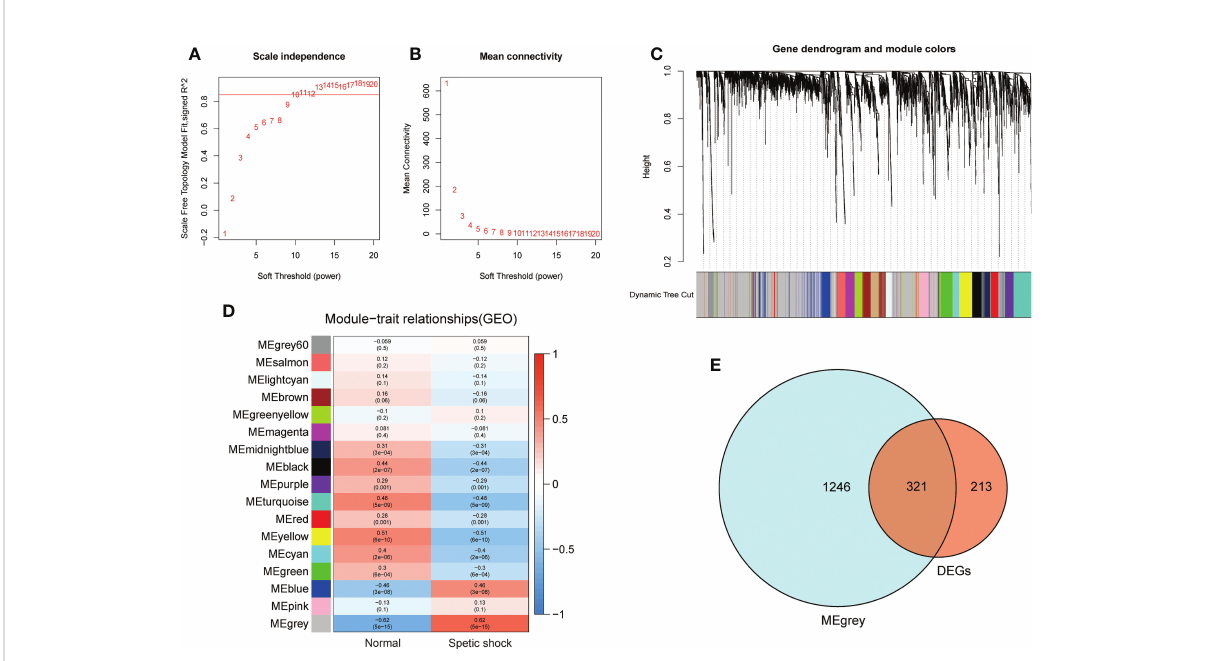
FIGURE 4 The WGCNA analysis of GSE26440 and identi fi cation of candidate hub genes. (A) The soft threshold power of WGCNA. (B) The mean connectivity of WGCNA. (C) The cluster dendrogram of WGCNA. (D) The clustered modules of WGCNA. (E) The veen plot showed the interaction between DEGs and genes in MEgrey